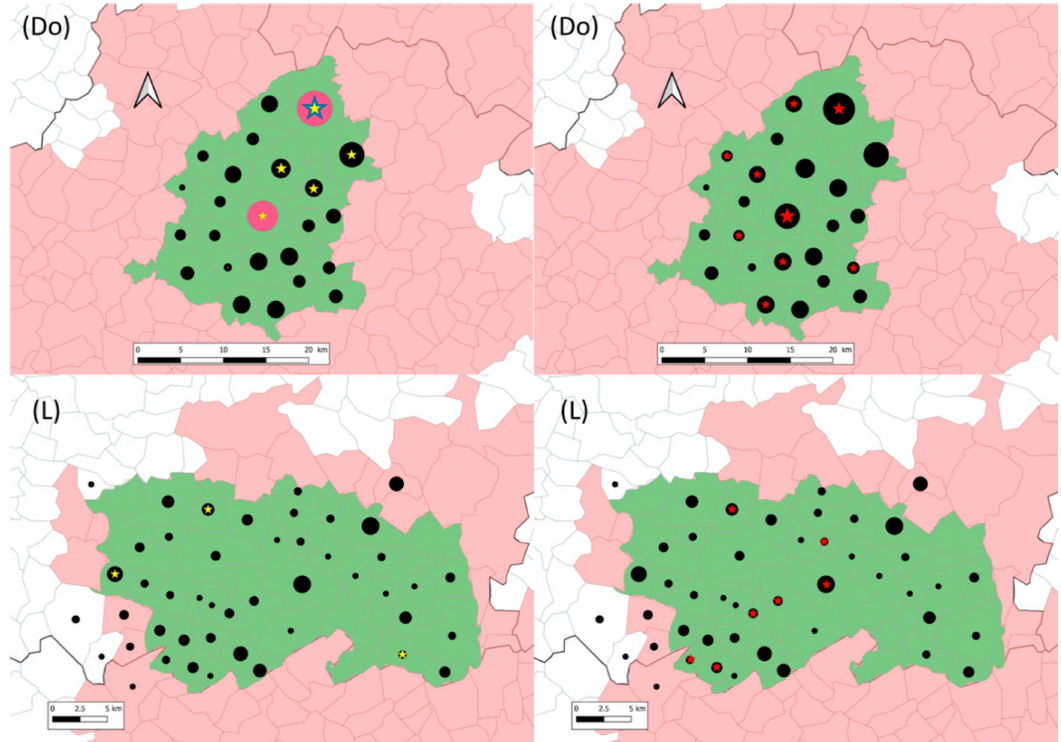
Figure 2. Location of sampled (black dots), M. microti infected (yellow (season #1) and blue (season #2) stars) and M. bovis infected (red stars) foxes in the Dordogne (Do) and Landes (L) study areas (in green). In Dordogne, red circles represent season #2 sampling in hotspot 1 and 2. The grey lines delimit communes (administrative units). The communes in pink belong to the infected areas where surveillance and management are implemented in cattle and in wildlife species (badgers, wild boars and red deer). Within them, the communes in green are those of included in this study. Black dots and stars are positioned at the center of the communes and their size is proportional to the number of foxes (1 to 27 foxes for dots and 1 to 16 foxes for